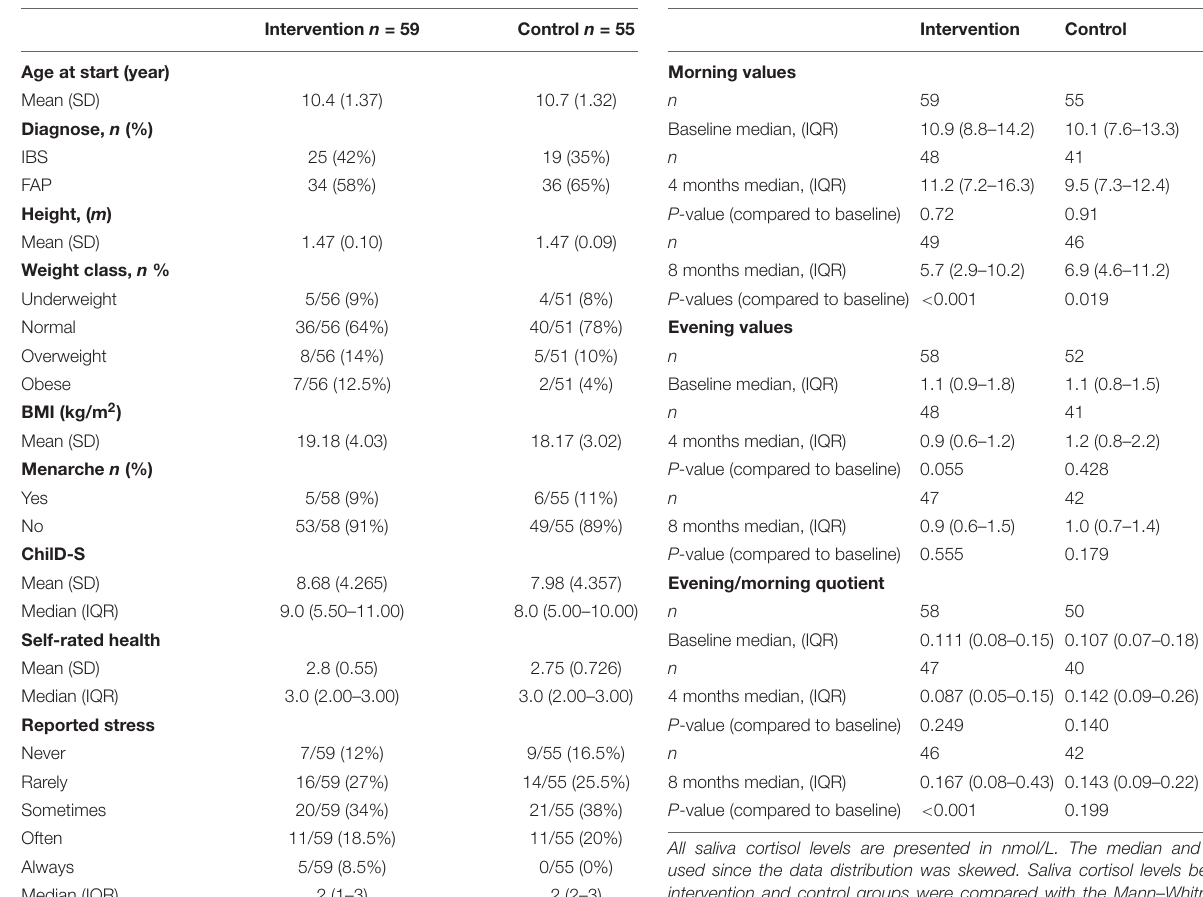
TABLE 1 | Baseline characteristics. TABLE 2 | Saliva cortisol levels at baseline and during the